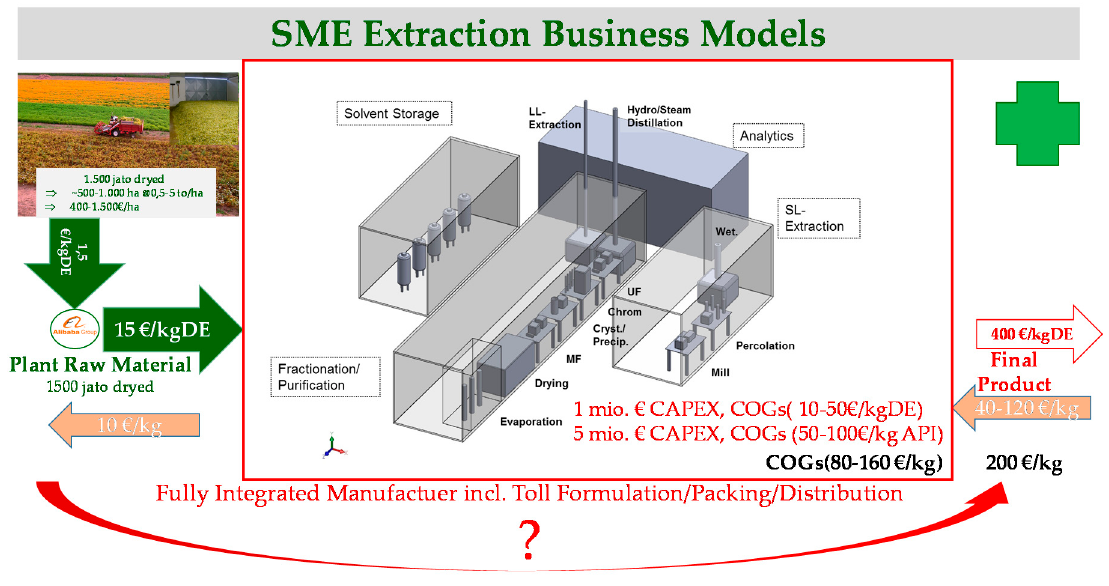
Figure 17. Business model for especially SMEs in phytomedicine manufacturing. CAPEX, capital expenditure; LL, Liquid-Liquid; MF, Microfiltration; UF, Ultrafiltration, SL, Solid-Liquid. (compare Figure 1).